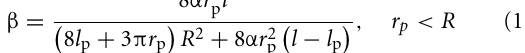
where α is the fraction of sieve plate area composed of sieve pore r p and l p define the sieve plate pore dimensions: radius and